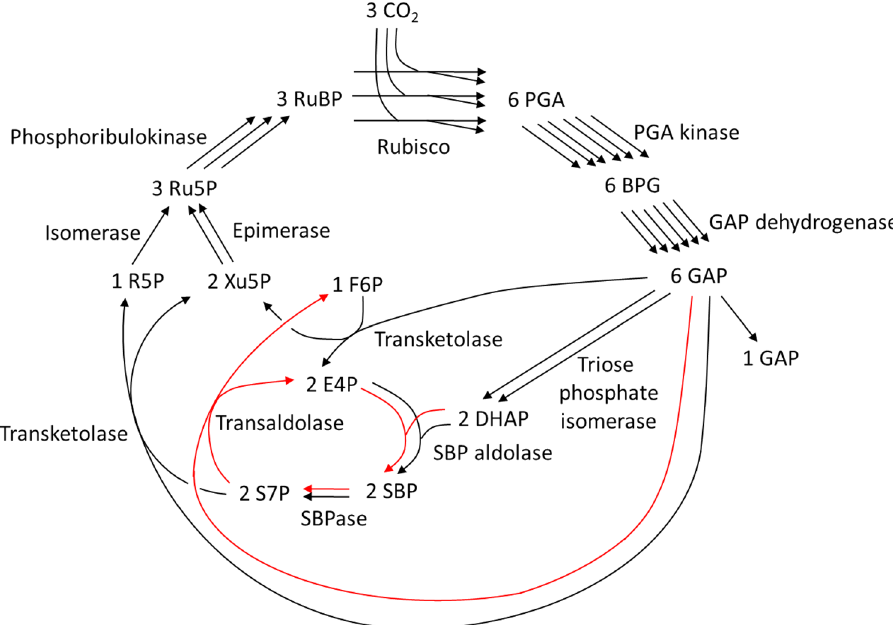
Figure 1. GAP formation from CO 2 through the S7P-removing transaldolase variant of the Calvin–Benson cycle. The reactions corresponding to the red arrows appear in neither the canonical Calvin–Benson cycle nor the S7P-forming transaldolase variant. GAP and S7P indicate glyceraldehyde 3-phosphate and sedoheptulose 7-phosphate, respectively. For other abbreviations, please see Table 1. The number before each metabolite, such as 3 for CO 2 and 6 for PGA, is equal to the number of arrows entering or exiting the metabolite. Currency metabolites are not shown. Currency metabolites include metabolites such as ATP, ADP, NADPH, NADP + , H +